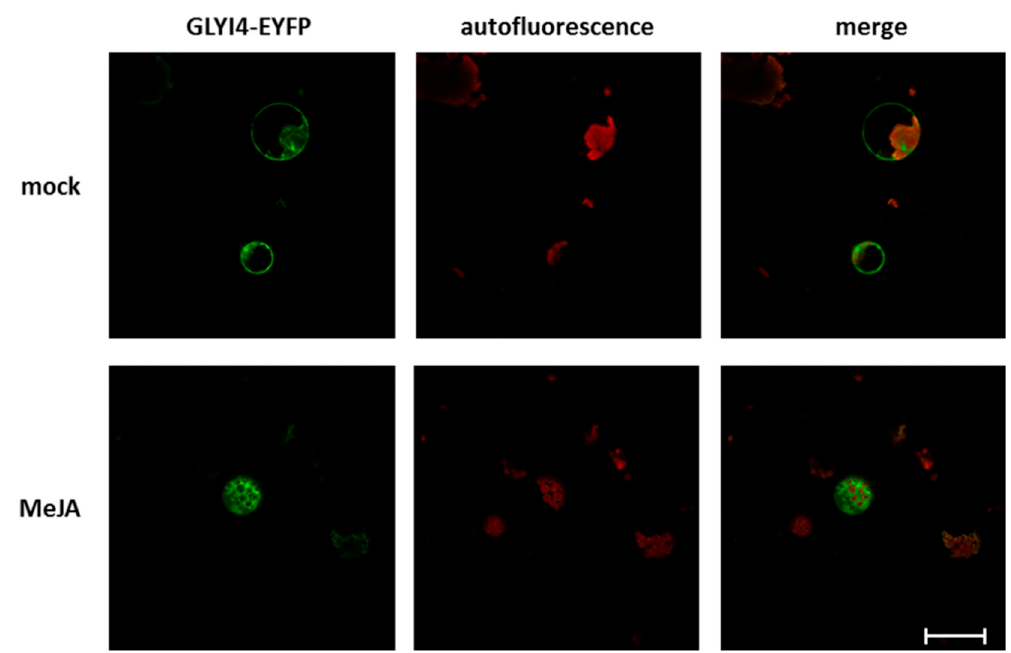
Figure 9. GLYI4 localization in Arabidopsis protoplasts. glyI4 leaf protoplasts were MeJA- and mock-treated and then transformed with pUC-35S::GLYI4- enhanced yellow fluorescent protein (EYFP). Fluorescence images were acquired using a Zeiss LSM 710 confocal microscope with Plan Neofluar 40/1.30 objective. Two laser excitation wavelengths were used (i.e., λ exc = 514 nm for EYFP (green), and λ exc = 561 nm for chloroplast autofluorescence (red)). The merged images are also presented. Bars correspond to 50 µm.